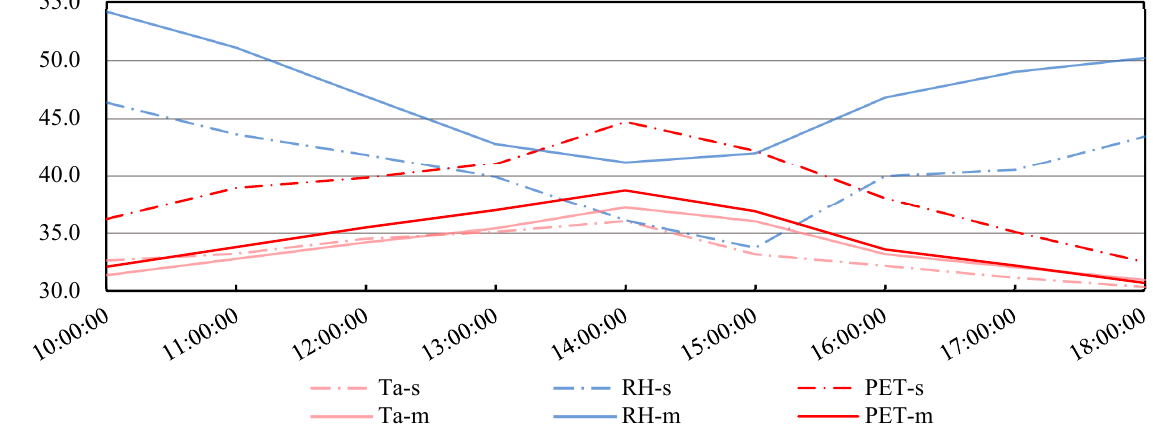
Figure 3. Model validation (s: simulation, m: measurement).